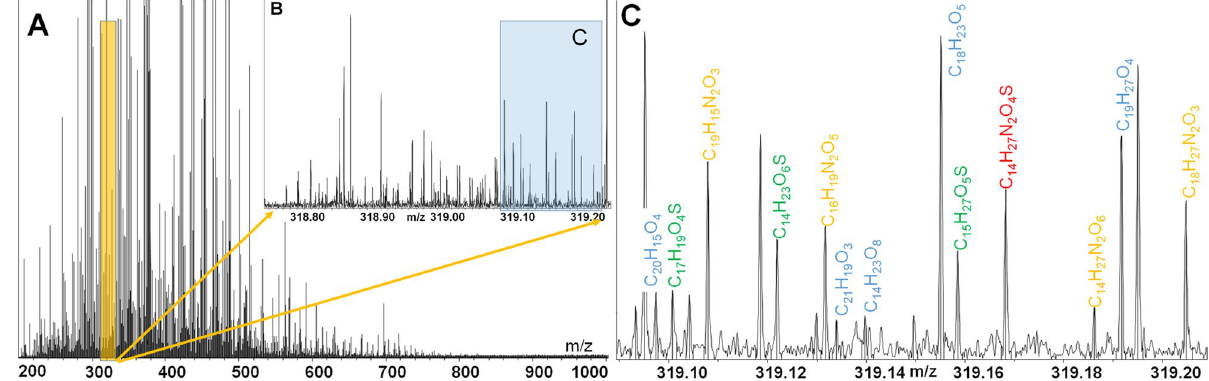
Figure 4. ( A ) FTICR mass-spectrum of alkali-extracted IOM (on the example of Murchison), ( B , C ) Insets show magnified fragments within 0.4 and 0.1 Da, respectively.